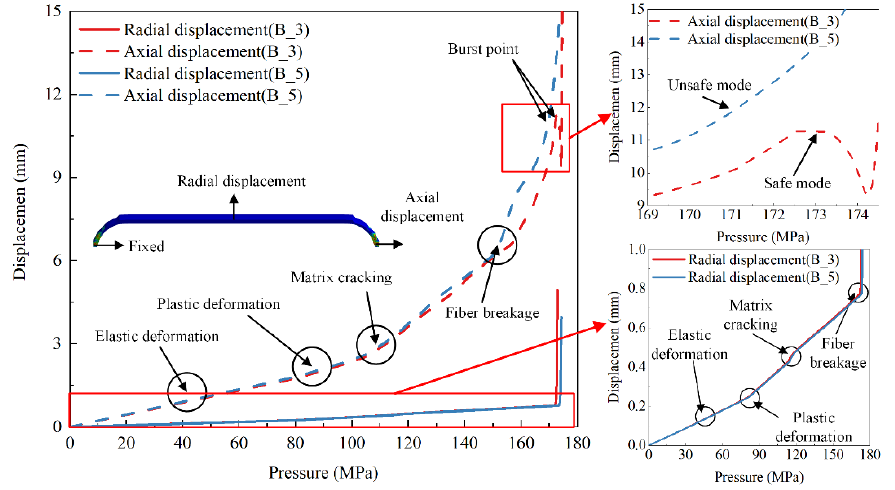
Figure 14. Comparison of numerical results of load-displacement curve between schemes B_3 and B_5.